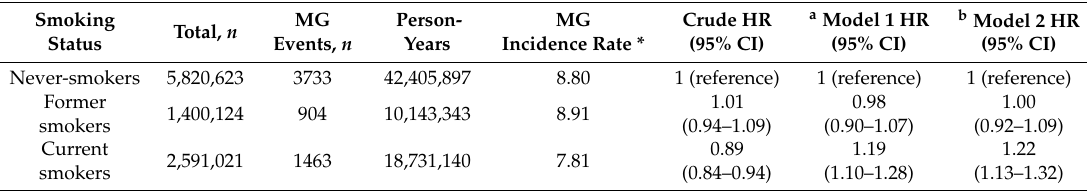
Table 2. Incidence rates and risk of malignant gliomas, according to smoking status.